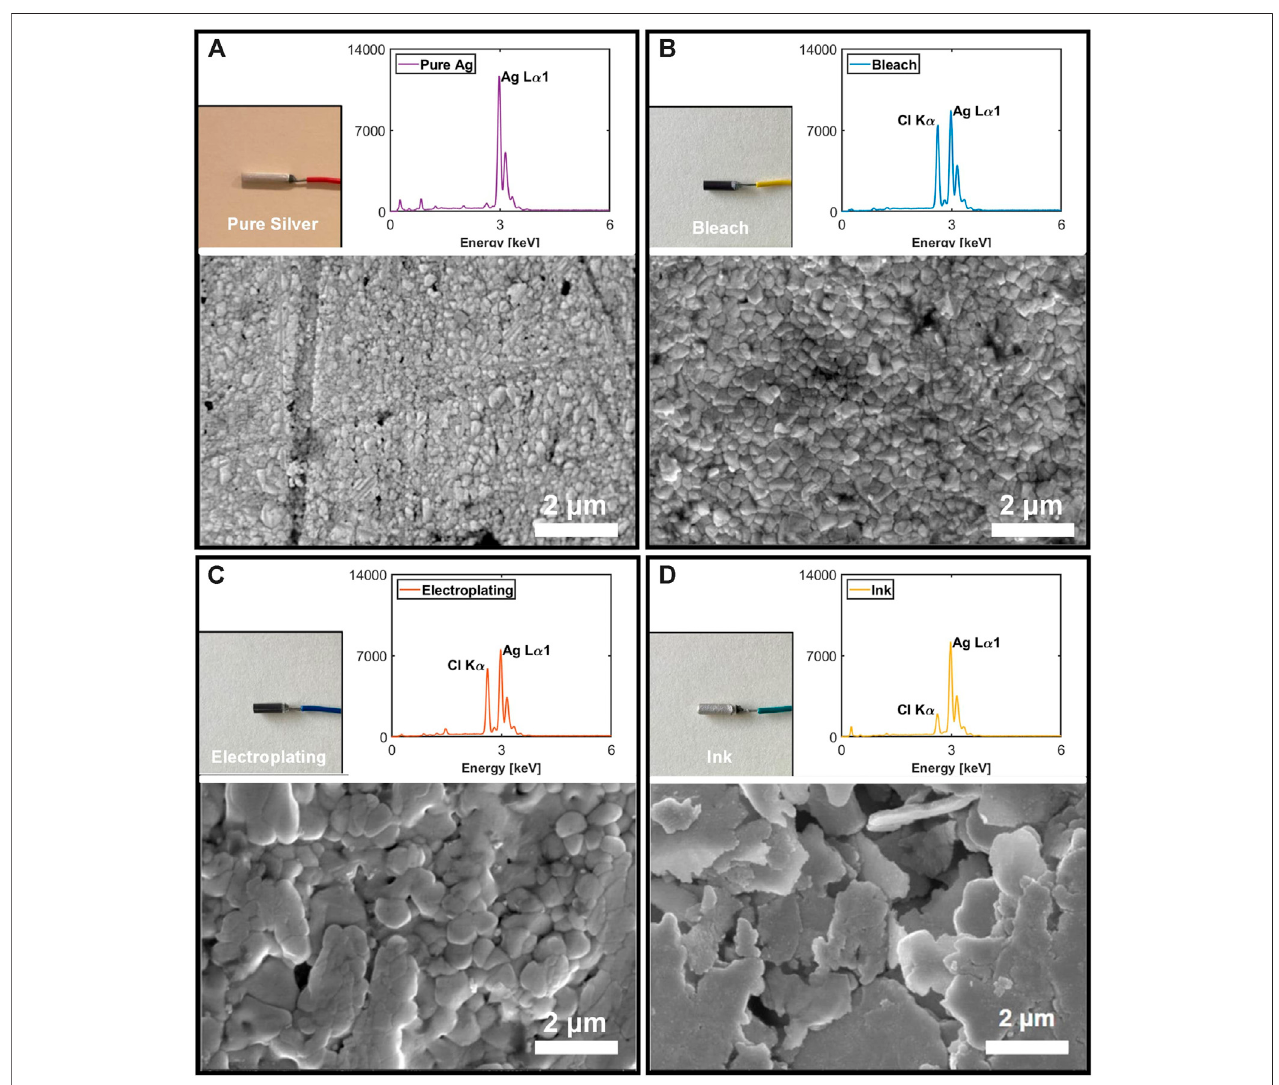
FIGURE 7 | Rod electrode image, EDX result, and SEM image for pure Ag (A) , bleach (B) , electroplating (C) , and ink (D) .